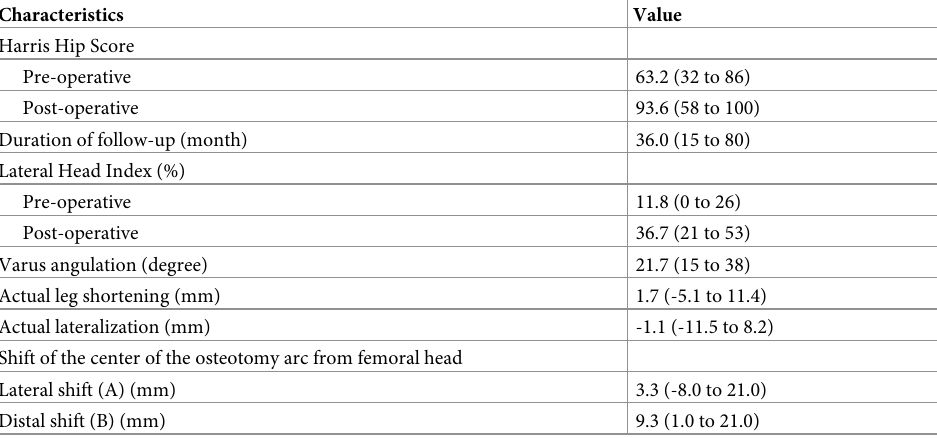
Table 2. Clinical and radiographic